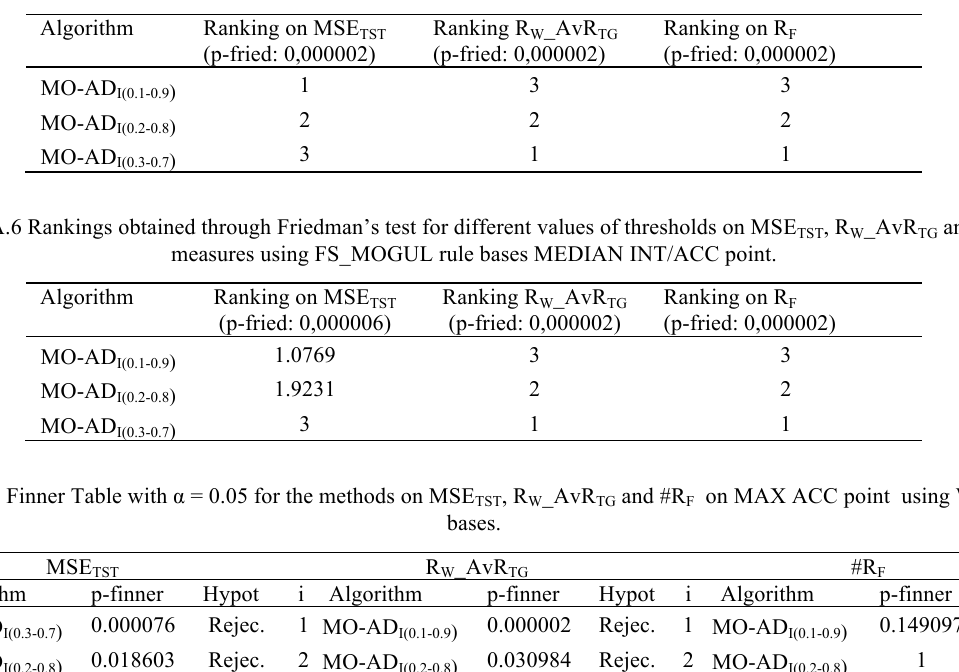
Table A.5 Rankings obtained through Friedman’s test for different values of thresholds on MSE TST , R W _AvR TG and #R F measures using WM rule bases for MEDIAN INT/ACC point.